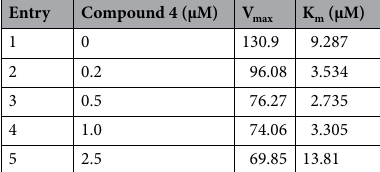
Table 2. Comparison of apparent V max and K m in the variation of compound 4 . V max and K m were determined by using Michaelis–Menten equation.